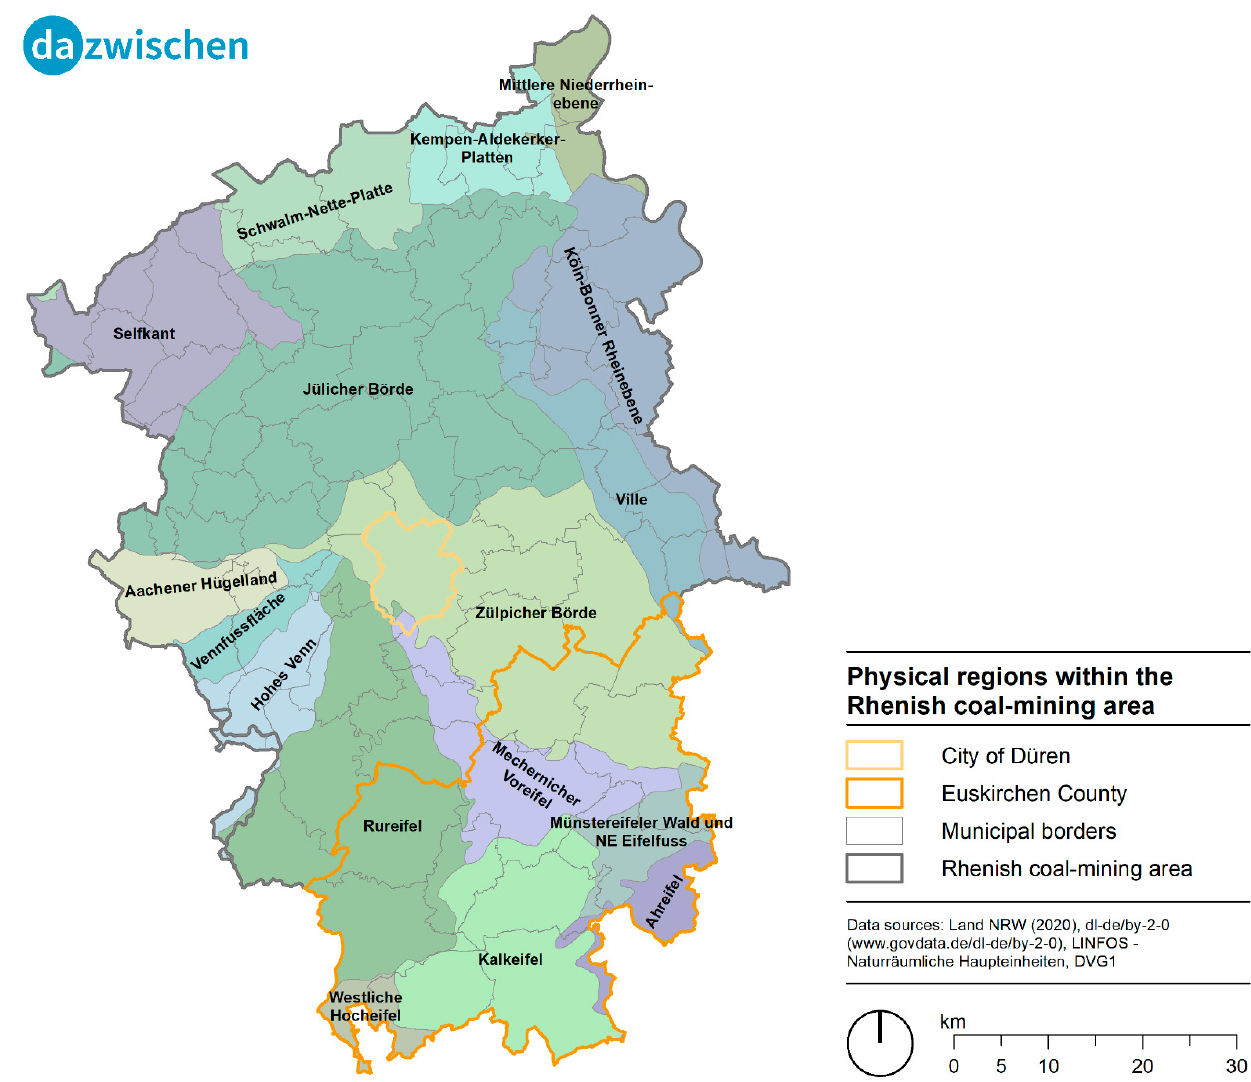
Figure 5. Physical regions within the Rhenish coal-mining area. Source: own Figure. While the lowlands in the northeast comprise “Jülicher Börde”, “Zülpicher Börde”, and all other landscapes north from the two mentioned landscapes, the average mountain landscapes are located south from “Jülicher Börde” and “Zülpicher Börde”. Because of the high fertility of the loess soils, the Börde landscapes, at least since Roman times, have been, to a high extent, used as arable land. The soil quality in the hilly average mountain landscape is much lower, leading to a higher degree of grassland and forests, with the consequence of more diversified habitats and a rich, attractive, and partly protected landscape, which can be used for recreational purposes, as well (Figure 6).